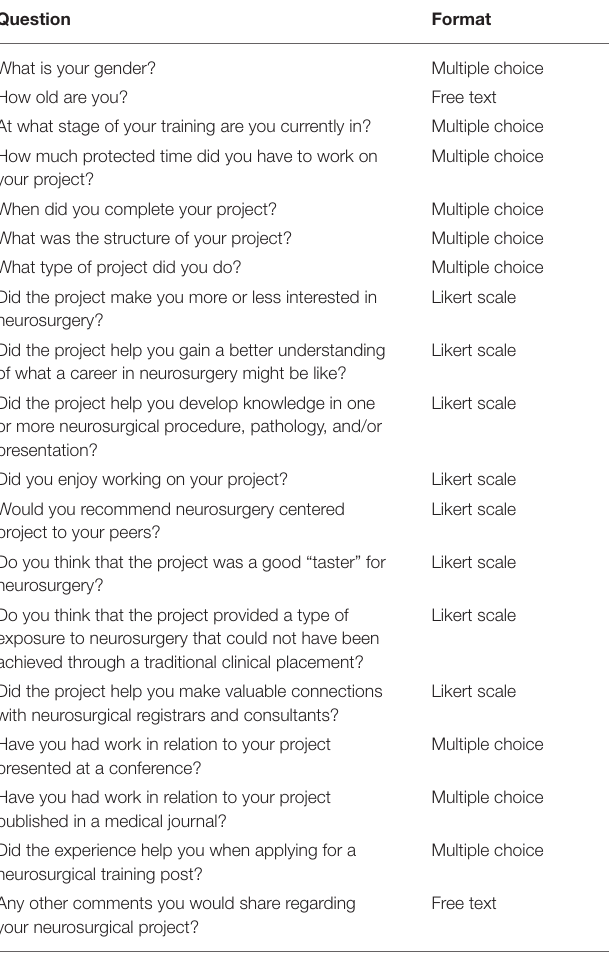
TABLE 1 | The list of questions included in the online survey.